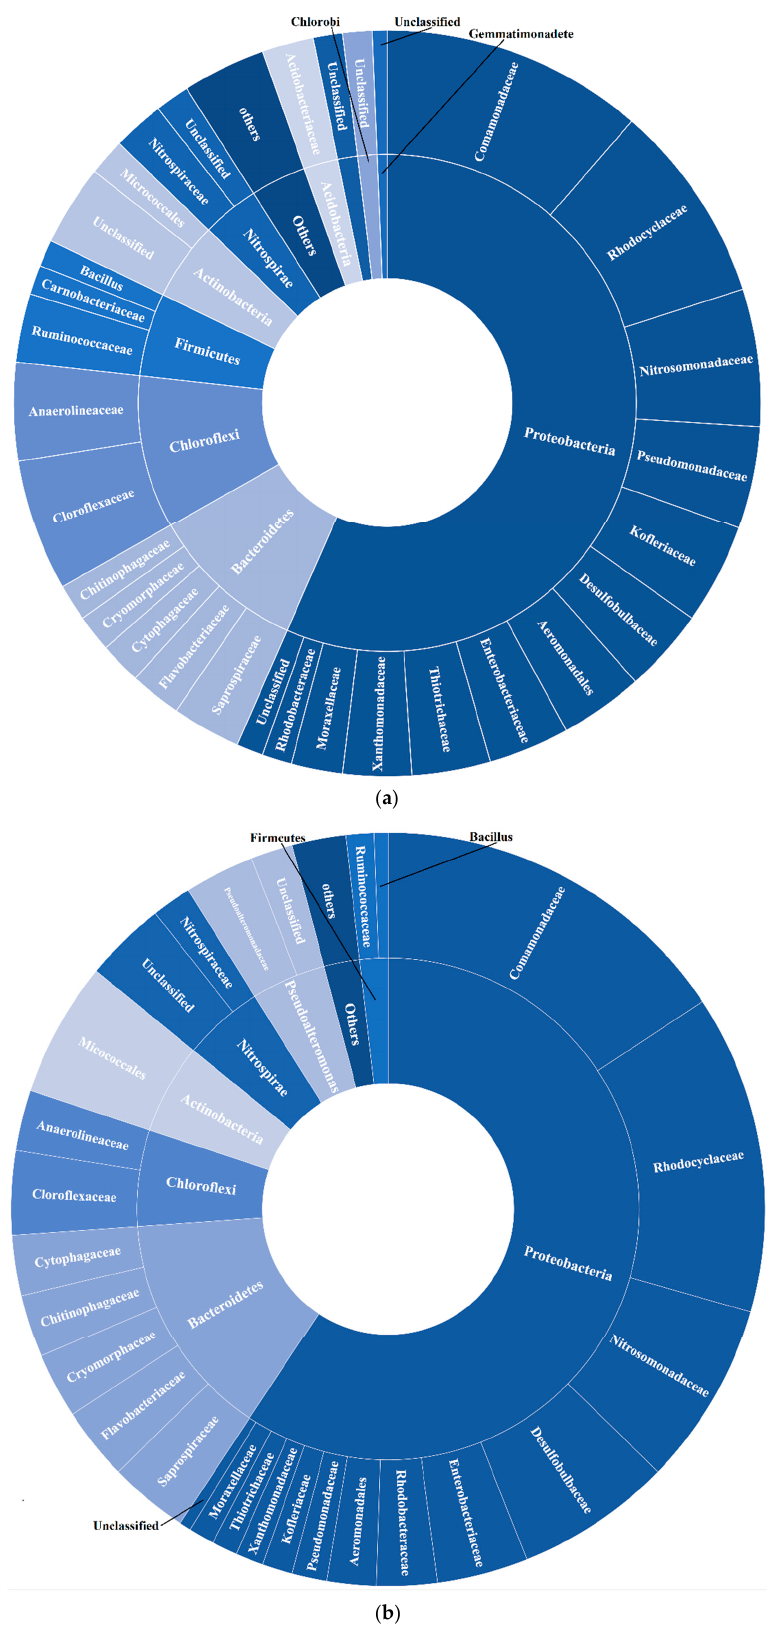
Figure 2. The microbial community in activated sludge before ( a ) and after ( b ) the operation in reactor 1. As shown in Figure 3, the biomass concentration in reactor 1 was much greater than in reactor 2, which is consistent with the findings of Berthold et al. [46].